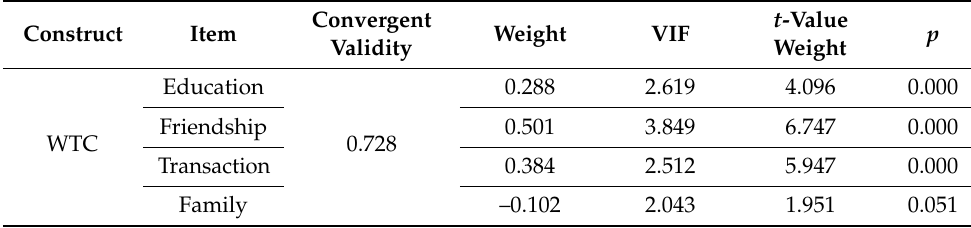
Table 3. Measurement properties of the formative construct